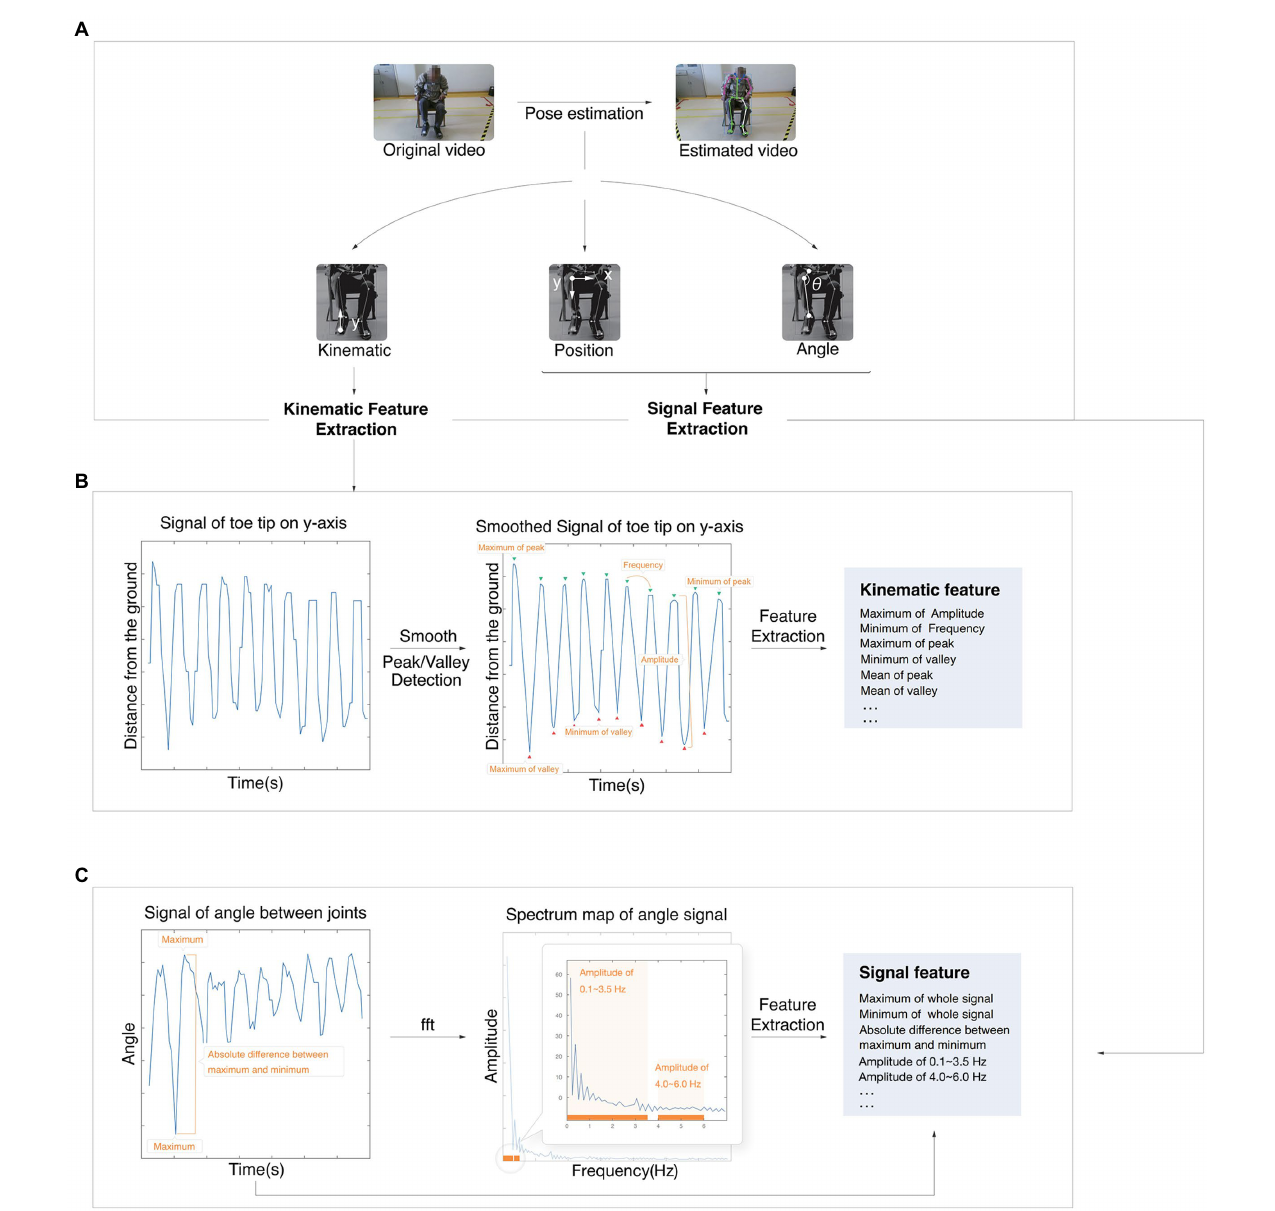
FIGURE 2 Process of the feature calculation. (A) The process from original video to estimated video. (B) Example of a kinematic feature calculation. (C) Example of signal feature calculation. fft, fast Fourier transform